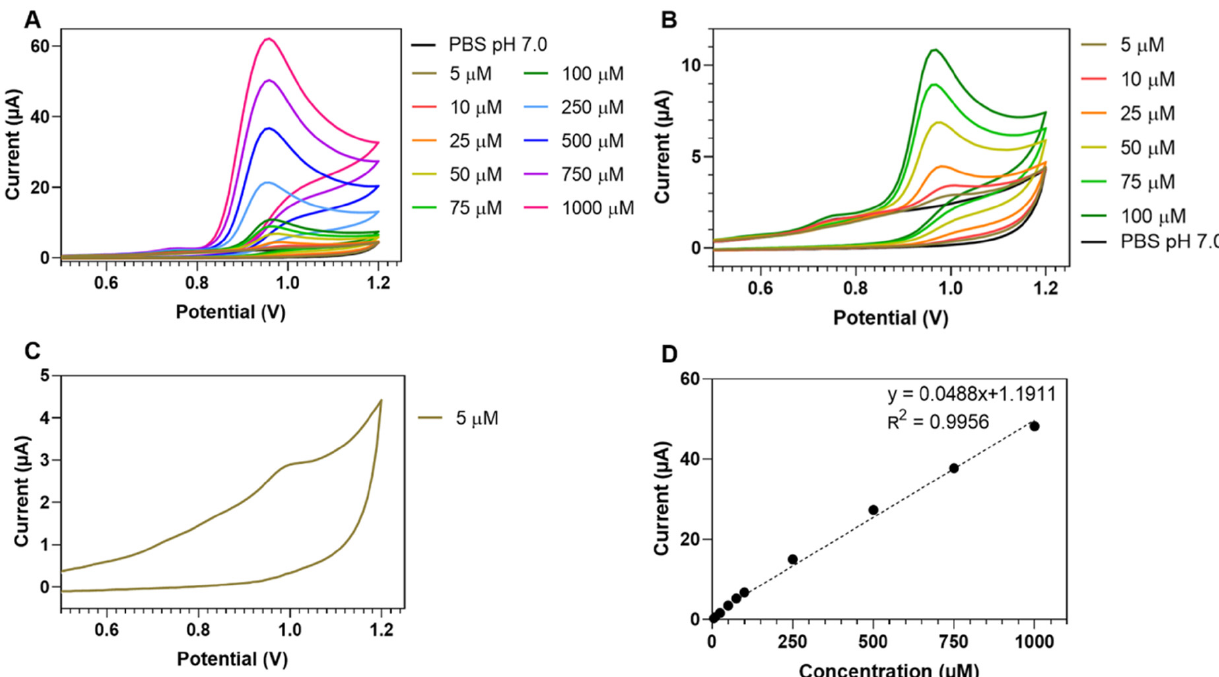
Figure 1. Cyclic voltammograms (CVs) from a 3-mm-diameter BDD disk electrode in 0.1 M PBS pH 7.0 and in 0.1 M PBS pH 7.0 with 5–1000 μ M 4NP ( A ). Zoomed CV display for 5–100 μ M 4NP ( B ) and 5 μ M 4NP ( C ). Calibration plot (mean 4NP CV peak current values from threefold repeats vs. actual 4NP level) for 4NP cyclic voltammetry at BDD disk working electrodes ( D ). Note: Error bars in ( D ) are smaller than the symbols of the data points. CV scan speed was 0.05 V s − 1 .